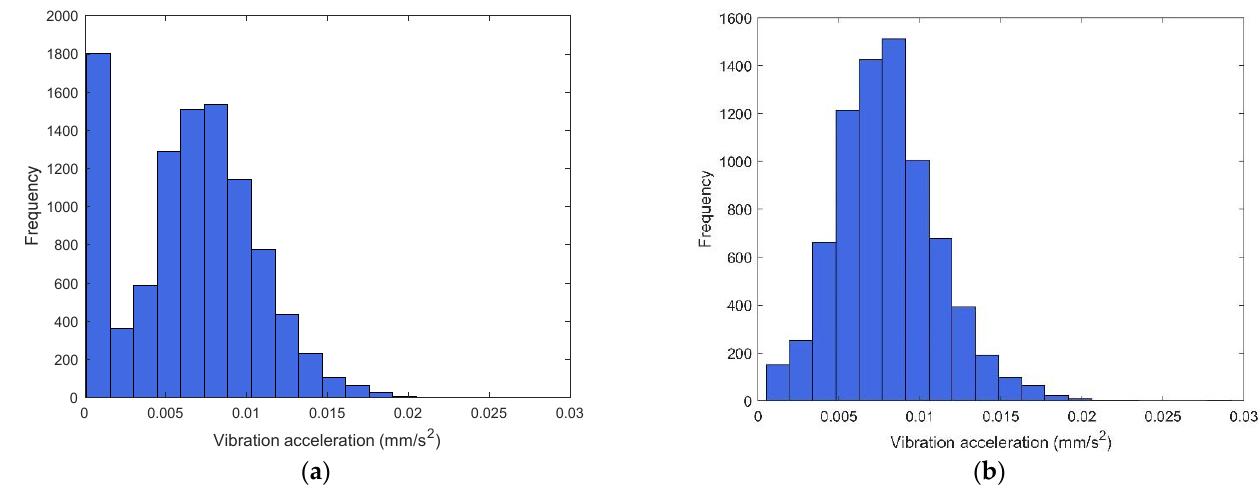
Figure 4. Frequency distribution of vibrational acceleration. ( a ) All vibration data of the wind turbine; ( b ) the vibration data during the wind turbine operation.